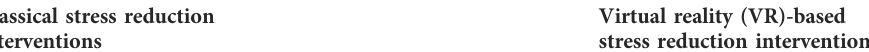
TABLE 1 Summary of classical and VR-based stress reduction interventions and relevant